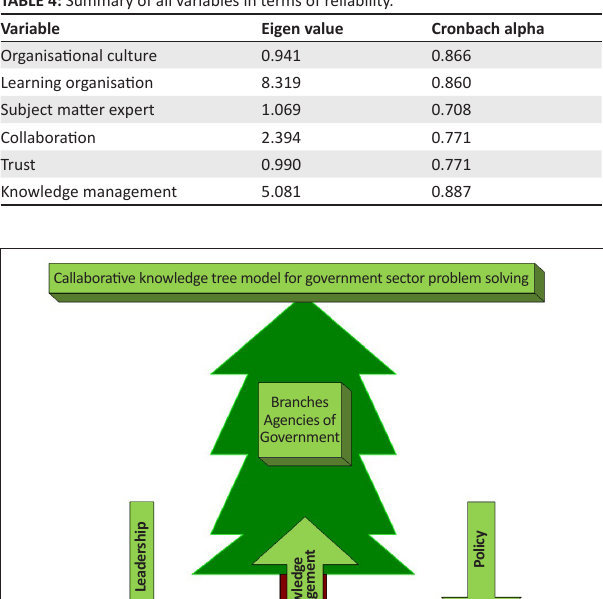
TABLE 4: Summary of all variables in terms of reliability.